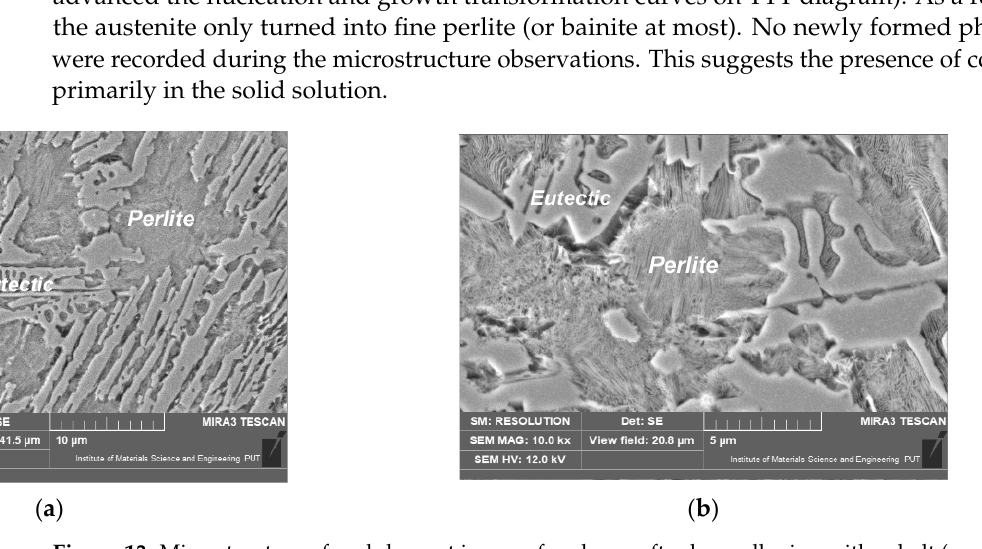
Figure 12. Microstructure of nodular cast iron surface layer, after laser alloying with silicon (scanning electron microscope, etched with nital 3%).